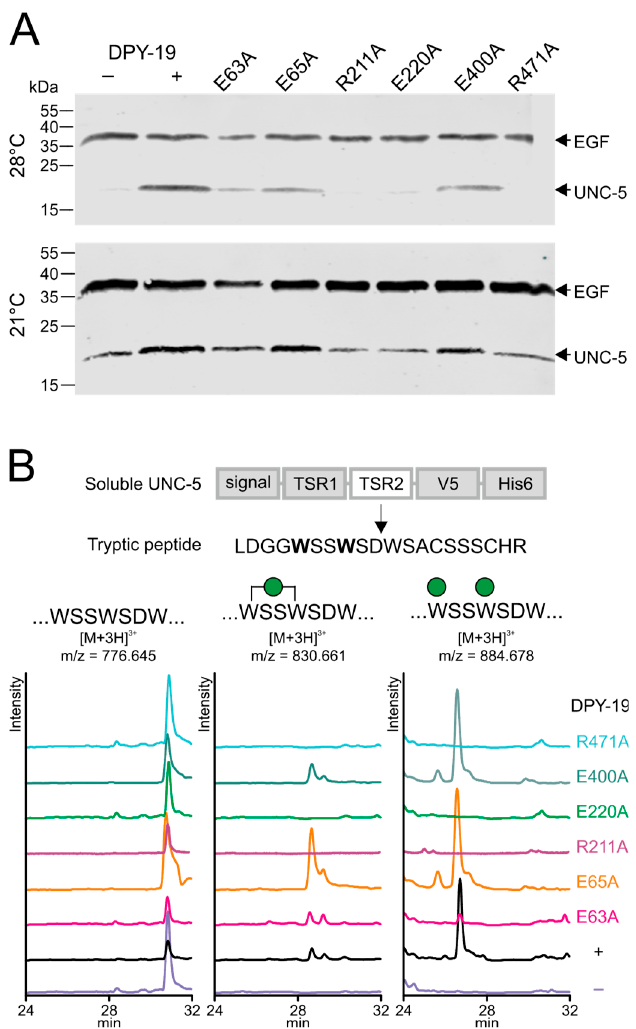
Figure 3. Secretion and C -mannosylation of an UNC-5 fragment modified by native and mutated C. elegans DPY-19. ( A ) Secretion of UNC-5 from S2 cells grown at 21 and 28 °C. A V5-His 6 -tagged UNC-5 construct encompassing the two TSRs was transfected in S2 cells without (-) or with (+) C. elegans DPY-19 or with C. elegans DPY-19 carrying the mutation E63A, E65A, R211A, E220A, E400A, or R471A. A plasmid expressing V5-tagged epidermial growth factor (EGF)-repeats 16–20 (EGF) of Drosophila melanogaster Notch was used as a transfection and secretion control. Transfected cells were grown at 21 or 28 °C, and secreted proteins were detected on Western blot using an anti-V5 antibody. ( B ) Extracted ion chromatograms of the unmodified, mono- C -mannosylated, and di- C -mannosylated TSR2 tryptic peptide LDGGWSSWSDWSACSSSCHR. All graphs are shown with equal intensities (13,000 counts per second).